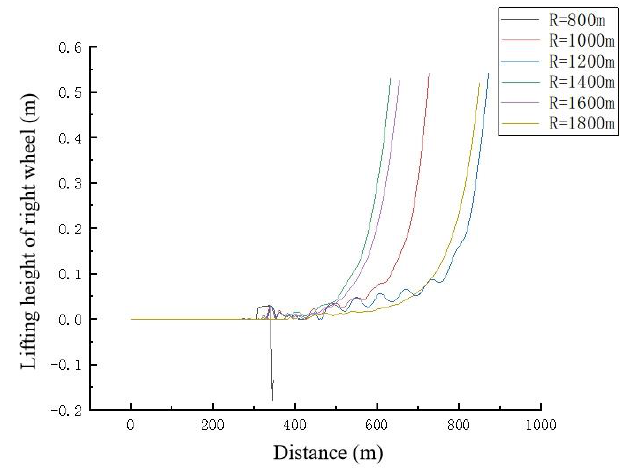
Figure 8. Wheel lifting height at inner rail side.